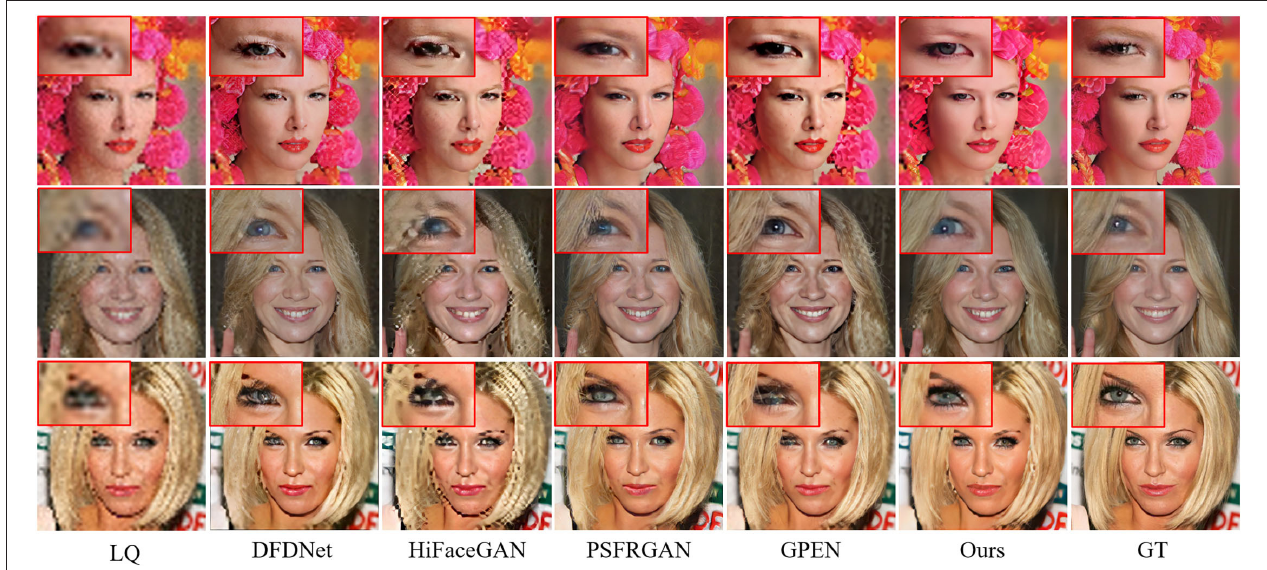
FIGURE 12 | Visual comparison achieved on CelebA-Test with the noise level set at 5.